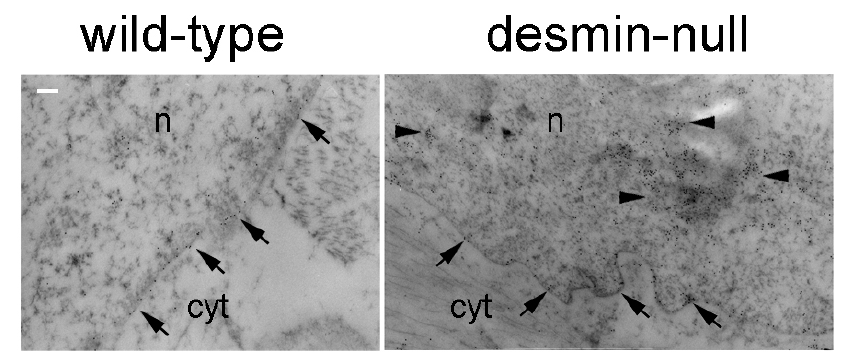
Figure 5. Nucleoplasmic localization of lamin A/C is increased in the nuclei of desmin deficient cardiomyocytes. Electron microscopic analysis of cardiac tissue sections from wild-type and desmin-null mice, immunogold-labeled for lamin A/C. Lamin A/C-bound gold particles are evident at the nuclear periphery (arrows) of the wild-type nucleus and appear reduced in desmin-null nucleus. Nucleoplasmic accumulation of lamin A/C-bound gold particles is observed in the desmin-null nucleus (arrowheads). (n, nucleus; cyt, cytoplasm). Scale bar, 100 nm.